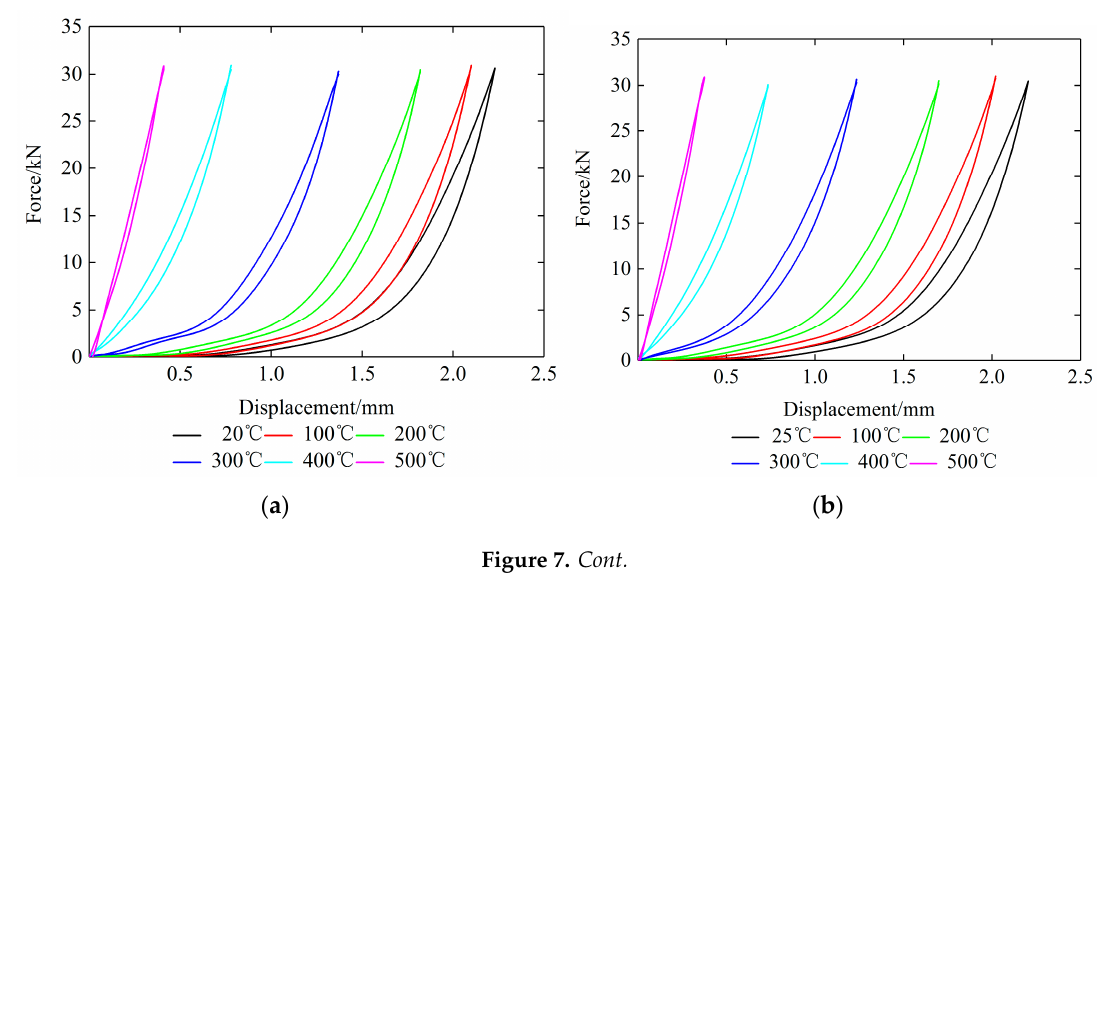
Figure 6. Secant of stress–strain curve.